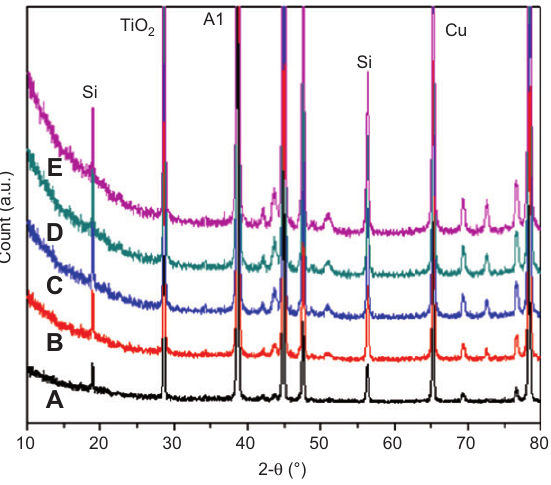
Figure 10 XRD patterns for particulate-filled A384 alloy compos- ites. (A) 0 wt.- % micro-TiO micro-TiO . (D) 6 wt.- % micro-TiO 2